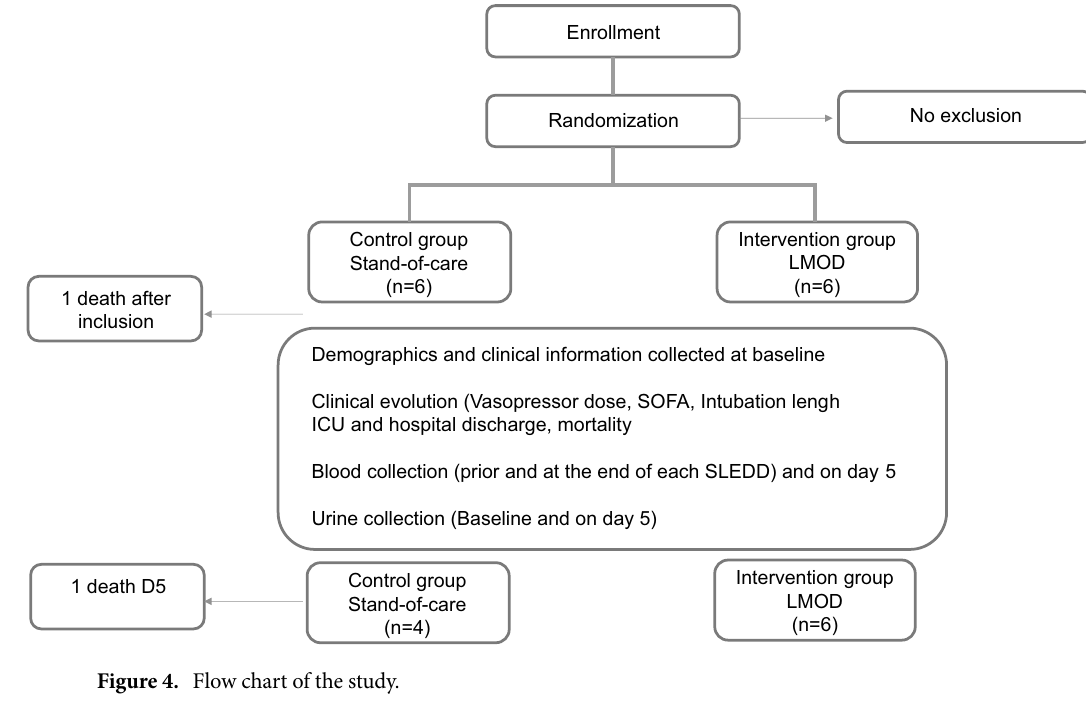
Figure 4. Flow chart of the